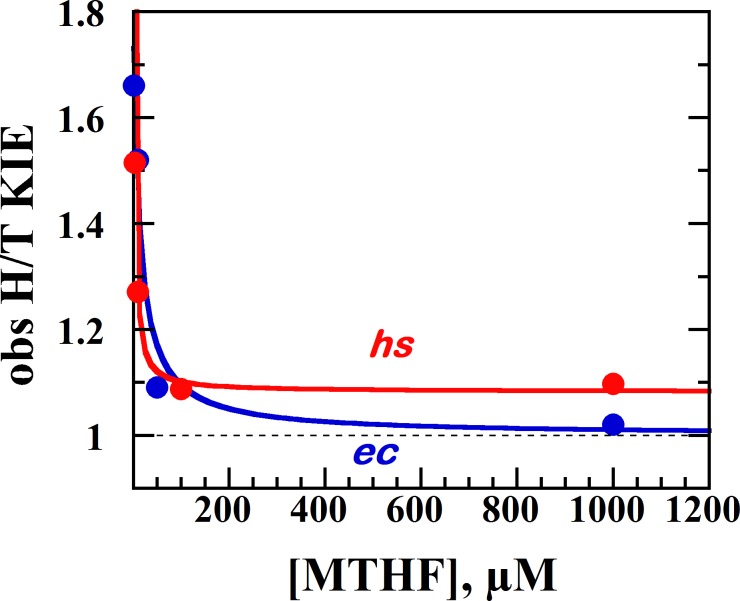
Observed KIEs on the proton abstraction vs the concentration of MTHF for ec[19] and hsTSase.